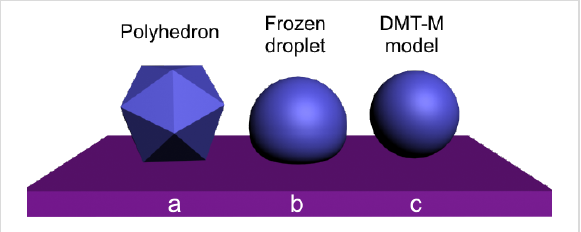
Figure 4: Different models for the estimation of the contact area: facet area of a polyhedron for Au NPs (a), frozen droplet for Ag NPs solidi- fied on a substrate (b), DMT-M model for Ag NPs solidified without contact to a substrate (c).